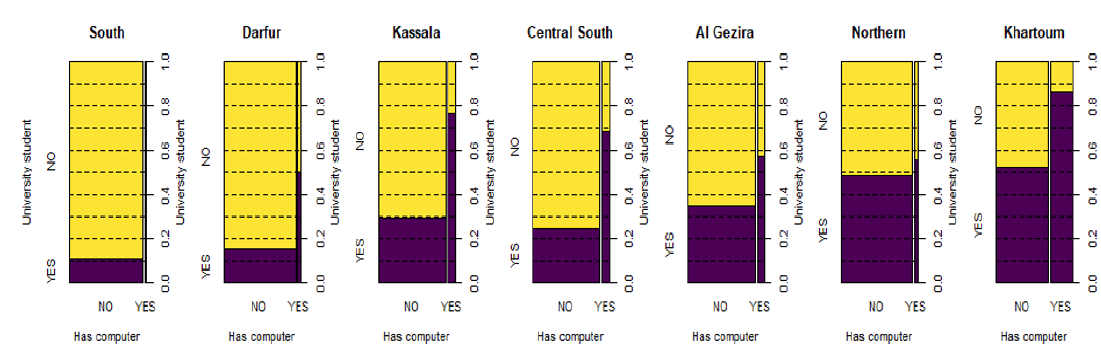
Figure 10. University attendance rates for 19–21-year-olds without or with computer, by region.